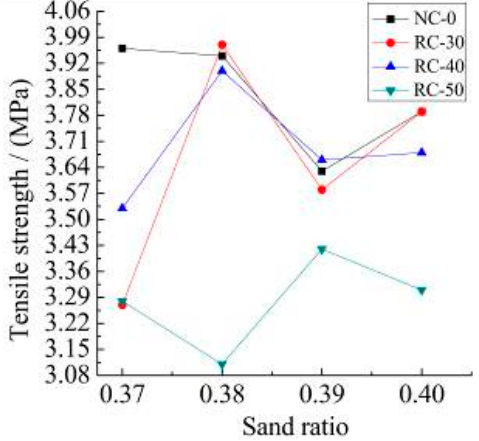
Figure 8. Measured tensile strength.